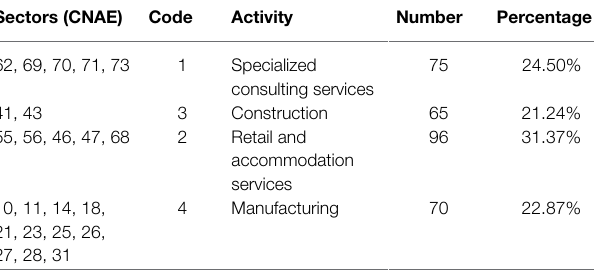
TABLE 2 | Sector and activity of the analyzed companies.